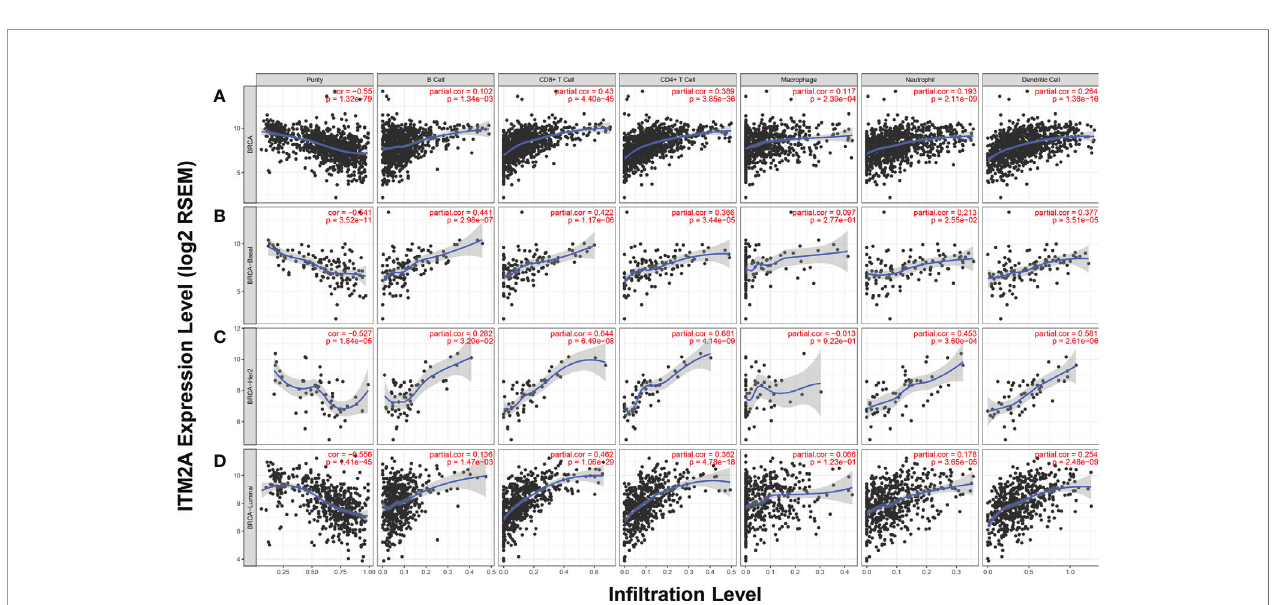
FIGURE 6 | ITM2A expression was positively correlated with TILs quantity. Correlations between ITM2A expression and six TILs types in breast cancer were evaluated based on TIMER database. Analysis in all subtypes of BC (A) , basal (B) , HER-2 (C) , and luminal subtypes (D)